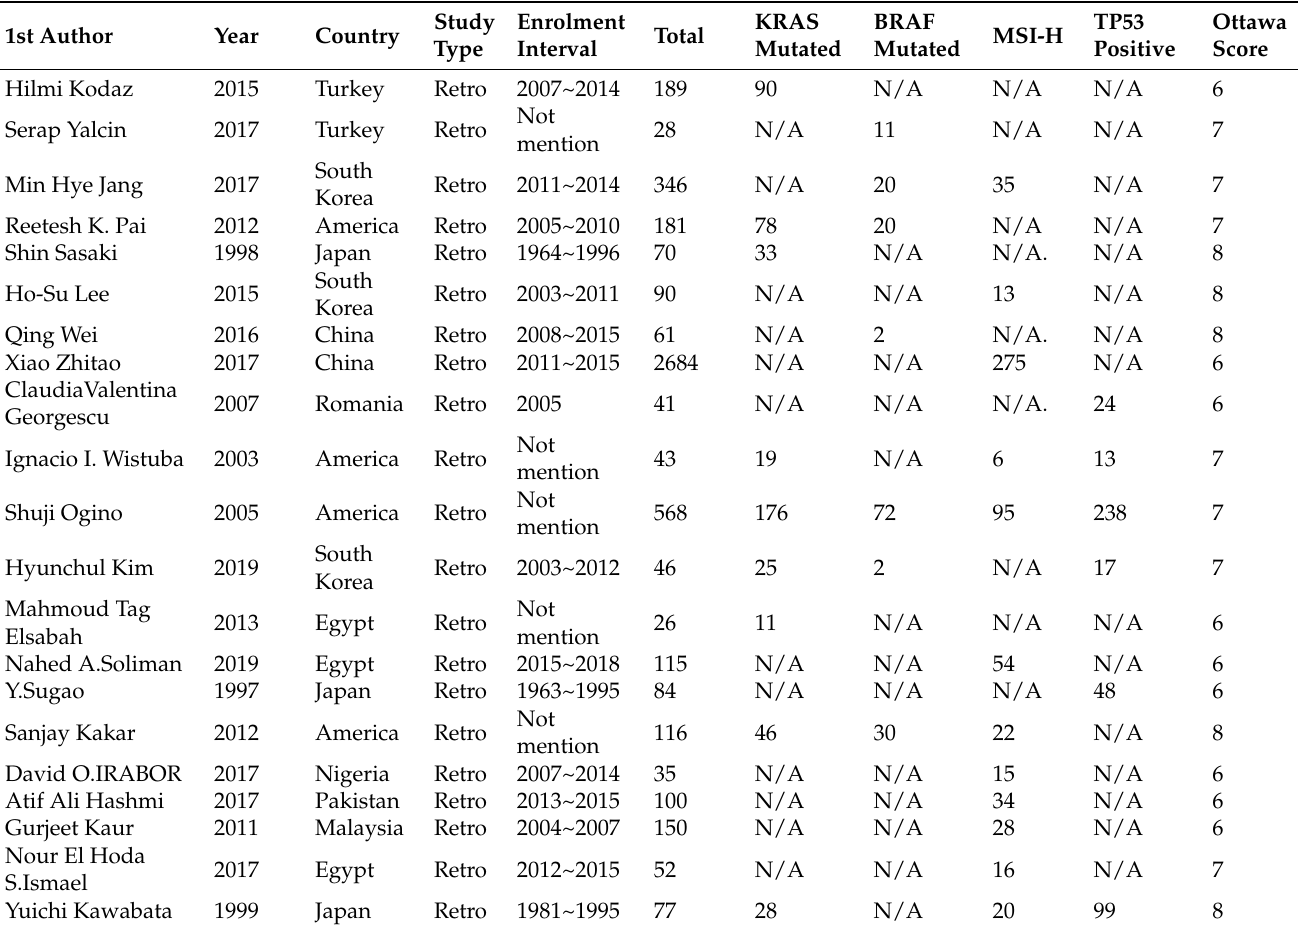
Table 1. Characteristics of included studies.